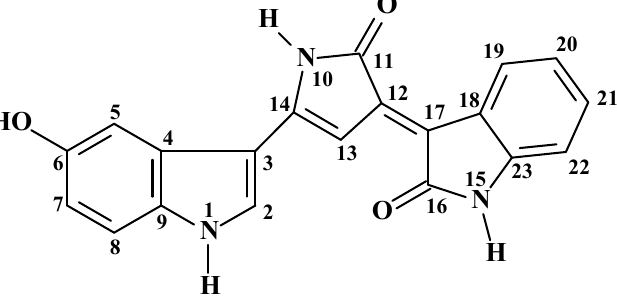
Figure 1. Structure of violacein from the NMR.